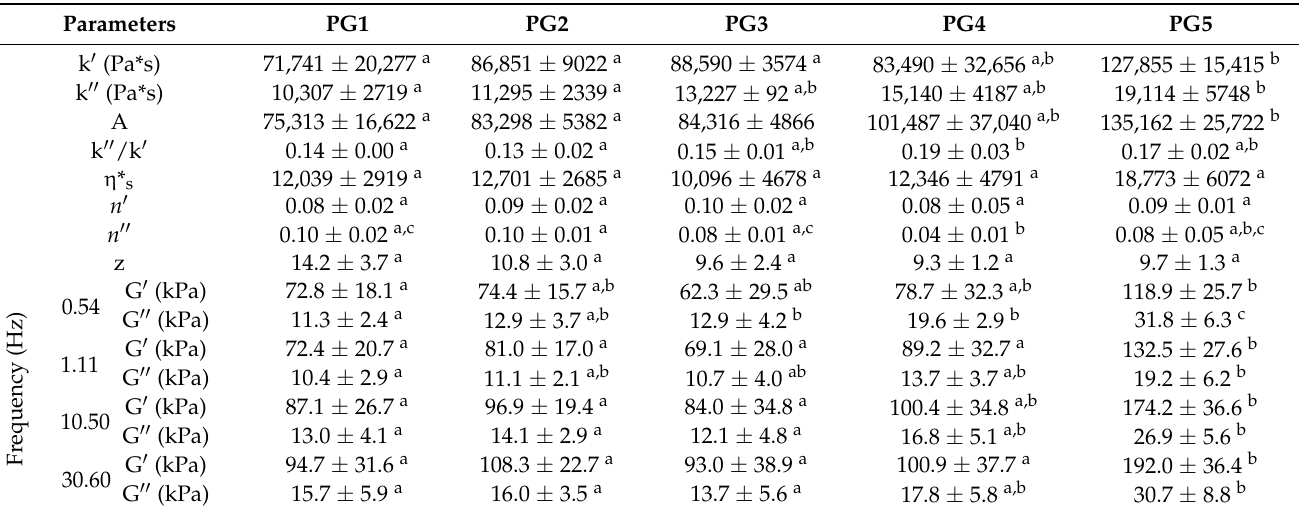
Table 2. Frequency dependence of viscoelastic parameters for pectin hydrogels PG1–PG5, viscosity, and frequency (0.3 < ω < 70.0 or at 0.54/1.11/10.50/30.60 Hz).